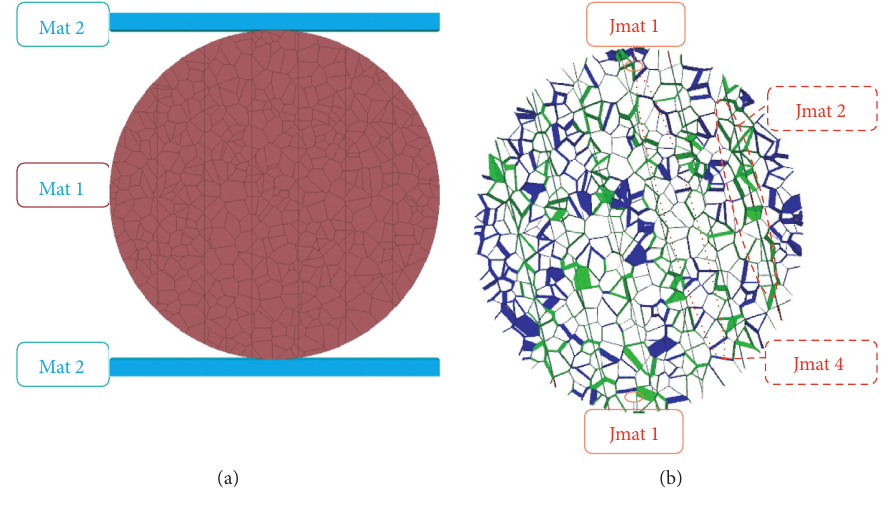
Figure 2: Brazilian disc model. (a) Blocks. (b) Joints.